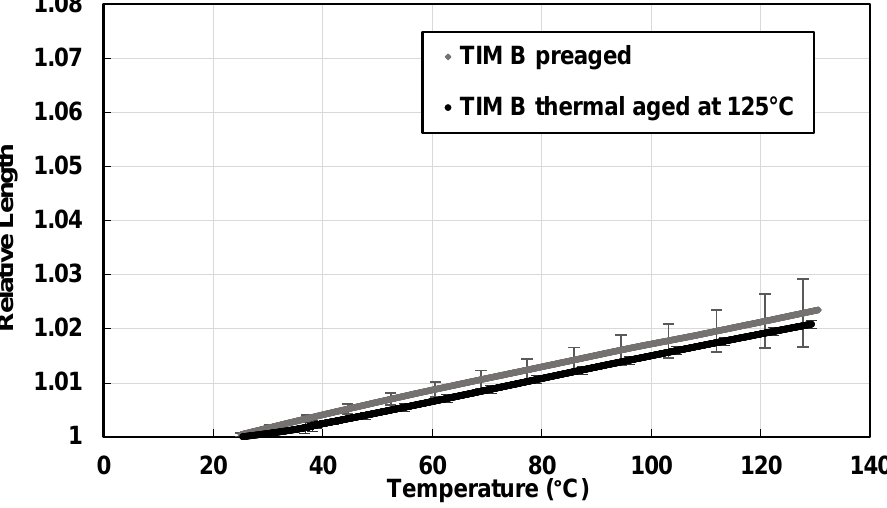
Figure 12. Change in relative length with temperature of TIM B.